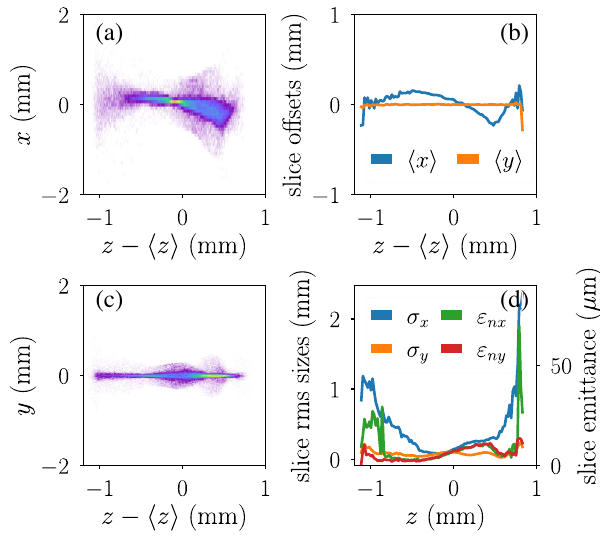
FIG. 17. Final ð z; x Þ (a) and ð z; y Þ (c) beam distributions corresponding to the data shown in Fig. 14, and slice analysis for positions h x i and h y i (b) and rms beam size and emittances